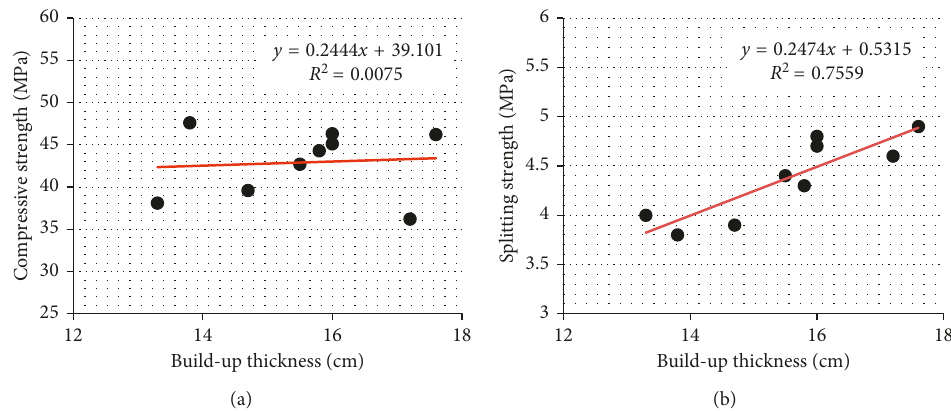
Figure 15: Correlation between shootability and compressive strength (a) and splitting strength (b).